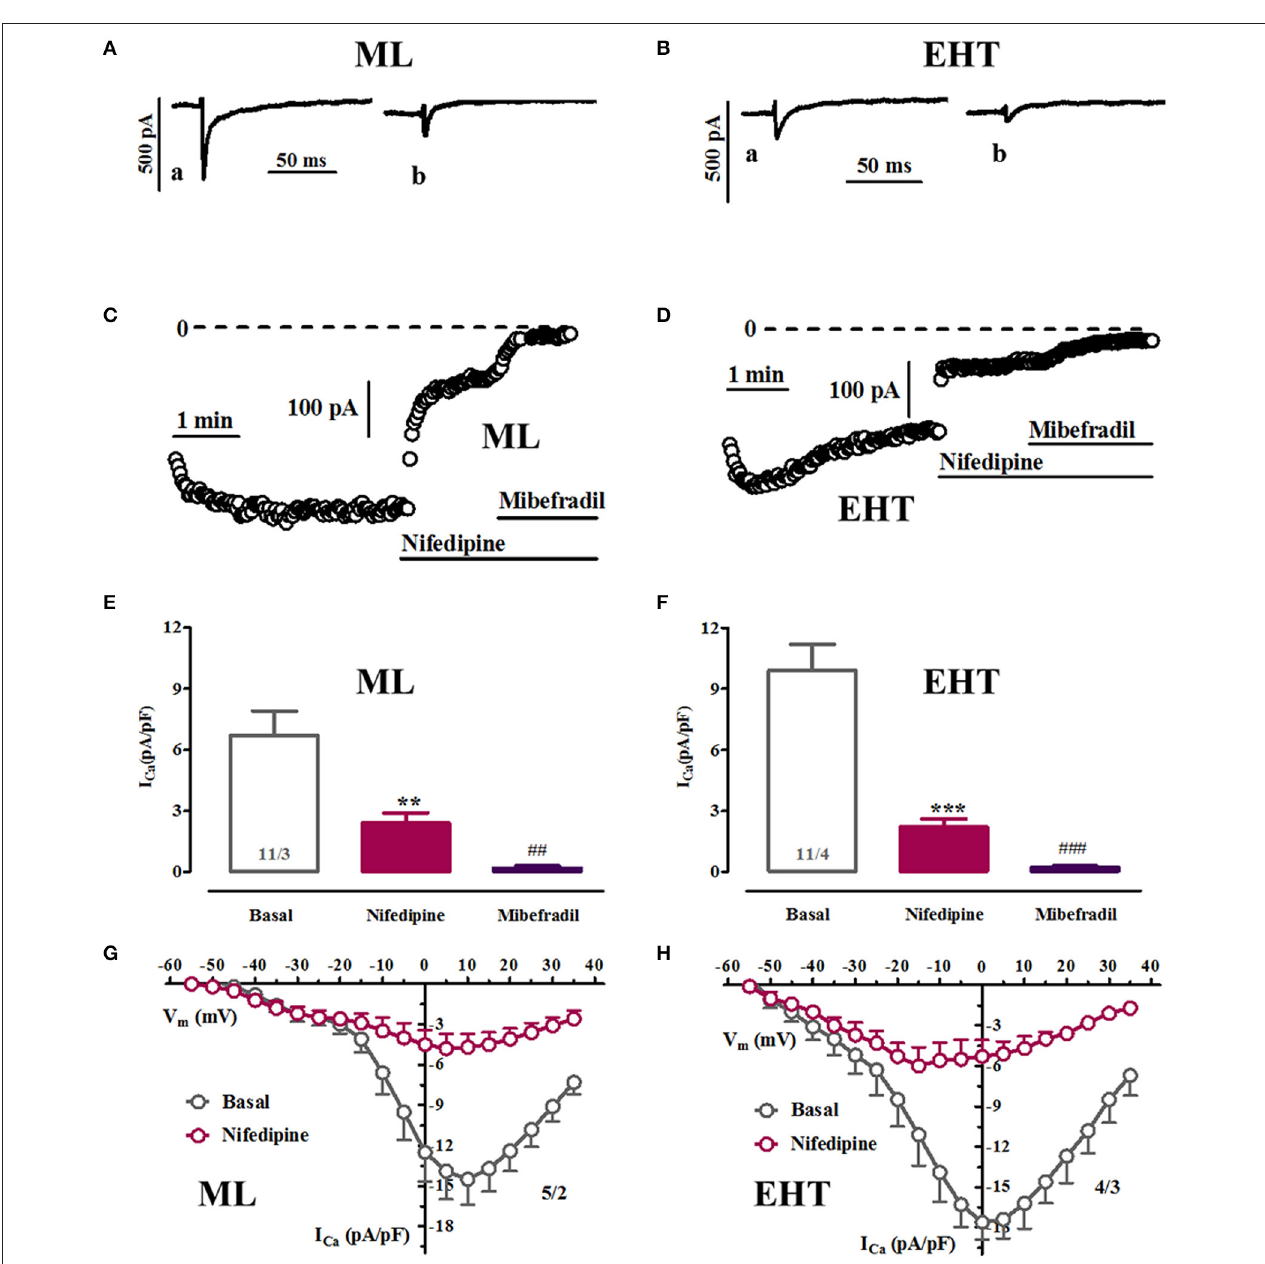
FIGURE 3 | Pharmacological discrimination of Ca 2 + -currents in ML and EHT. ML and EHT were exposed to nifedipine and mibefradil. (A–D) Respective time courses taken in ML (A,C) or EHT (B,D) from individual experiments. Original tracings taken at time points indicated as a and b. (E,F) : Ca 2 + -currents measured at + 10 mV in ML (E) and EHT (F) exposed to nifedipine (10 µ M) and on top to mibefradil (10 µ M). ** p < 0.05 and *** p < 0.001 vs. basal and ## p < 0.01 and ### p < 0.001 vs. nifedipine. (G,H) IV-curves recorded under control condition and in the presence of 10 µ M nifedipine in ML (G) and EHT (H) . N/N indicates number of cells vs. number of isolation for ML and